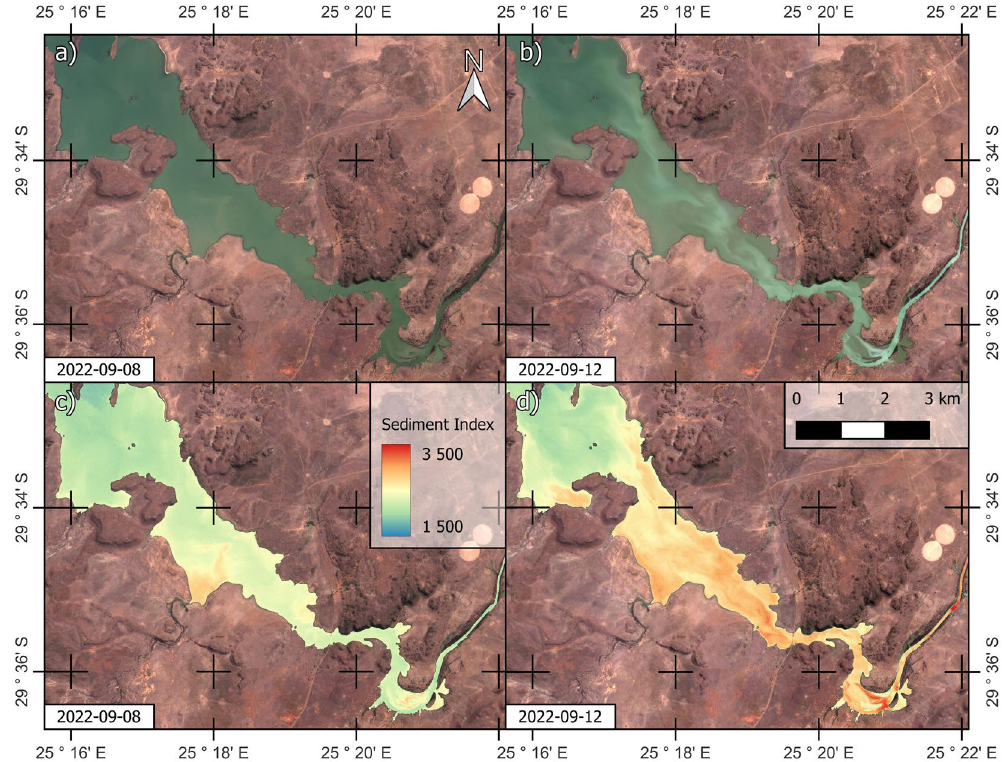
Figure 6. Pre and post-failure PlanetScope images of the upper part of the Kalkfontein dam. ( a ) and ( b ) Natural colour renderings. ( c ) and ( d ) Sediment index rendering. NB: Parts ( c ) and ( d ) share the same Sediment Index colour ramp. See greater context in Fig. 5d. Created using QGIS software version 3.26 (http:// www. QGIS.